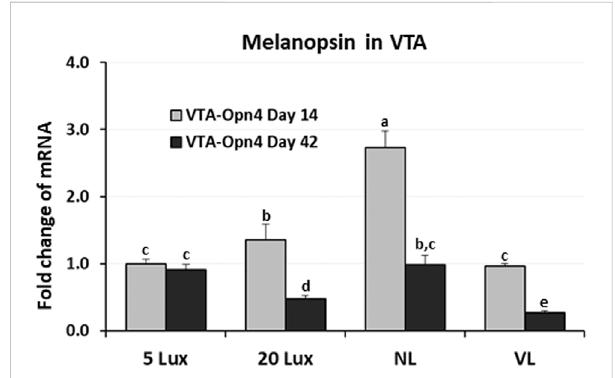
FIGURE 8 Expression changes of melanopsin (Opn4) mRNA in the VTA of birds at 14 and 42 days of age. Light intensity programs were changed at day 7 – 5, 20, 480 lx (NL house), 2 – 5 lx/40 lx (VL house). Brains of male bird were sampled on days 14 and 42 ( n = 12/section, 4 sections/house). VTA of the midbrain from each bird was dissected as described in Figure 5. Total RNA was extracted and used for RT-qPCR. Data were set as the relative fold changes of expression levels using the ΔΔ Ct method with GAPDH and β -actin as internal controls. Data (mean ± SEM) were expressed from a value set for 1.0 for 5 lx birds at 14 days of age. Different lower-case letters above the bars denote signi fi cant differences ( p < 0.05) among groups, where a > b > c and b,c is not different from b or